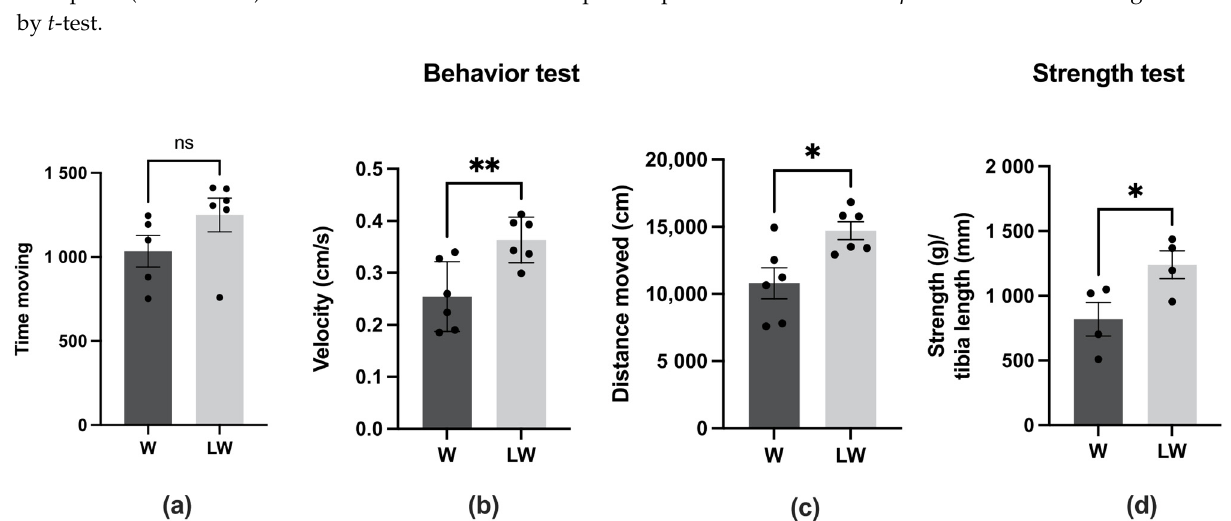
Figure 3. Evolution of behaviour and muscle force in tumour-bearing groups, fed or not the leucine-rich diet. Ecthovision behaviour parameters measured at night time. ( a ) Time moving, ( b ) Velocity and ( c ) Distance moved measured at endpoint moment. N = 6 animals per group. * p < 0.05, ** p < 0.01, and ns = not significant by t -test. Strength test measurement. ( d ): Strength (g) normalised by tibia length (mm) measured at endpoint moment, N = 4 animals per group. For details, see the Methods section. Graphics represent mean ± SEM. * p < 0.05, ** p < 0.01 and ns = not significant by t -test.